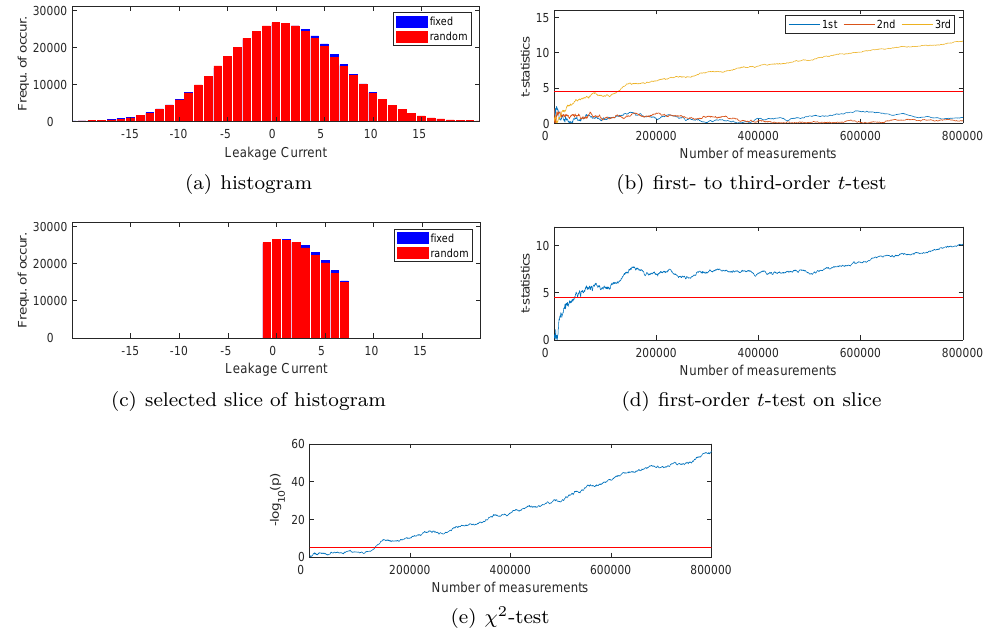
Figure 15: Leakage evaluation using 800,000 fixed vs. random measurements of a byte- serial AES threshold implementation in 65 nm CMOS technology, recorded at 90 ◦ C and 1 . 6